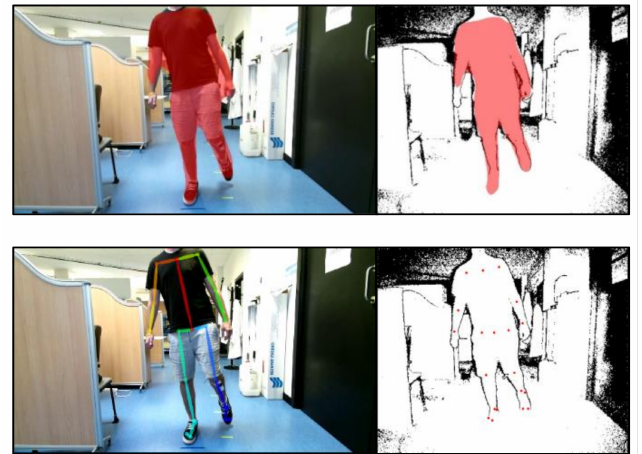
Figure 10. ( Up ) Correspondence between the mask in the RGB image and its calculated equivalent in the depth image. ( Down ) Correspondence between the OpenPose skeleton in the RGB image and its calculated equivalent in the depth image.